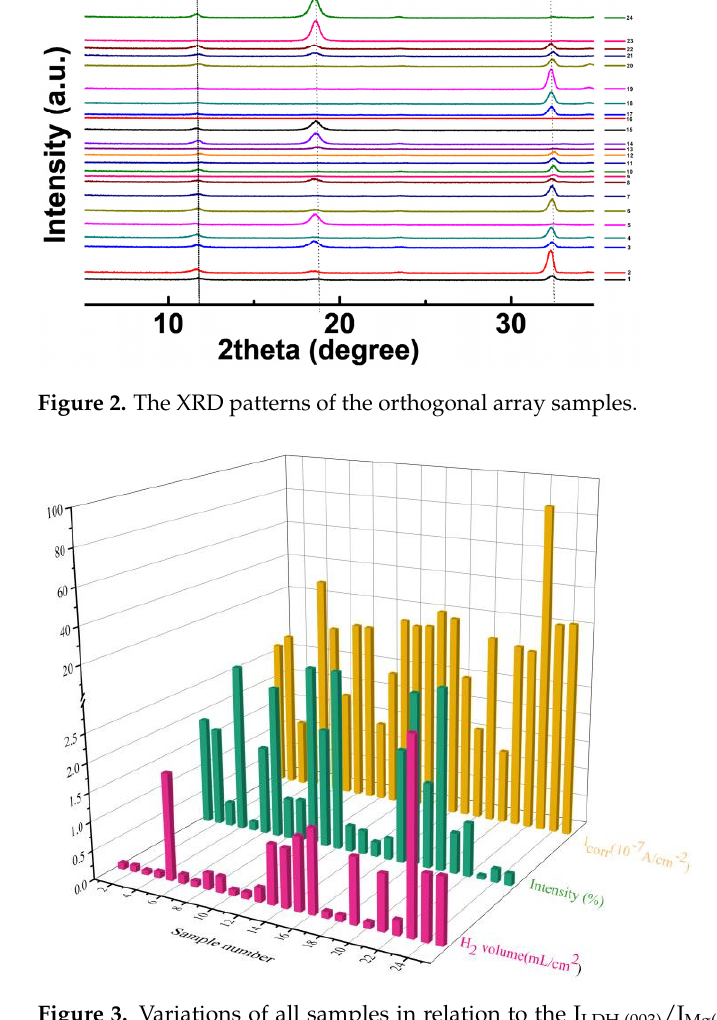
Figure 3. Variations of all samples in relation to the I LDH (003) /I Mg(OH)2 (001) (Intensity), HER (H 2 volume), and I corr ( I corr ). Table 3. Analysis of a range of orthogonal experiments.